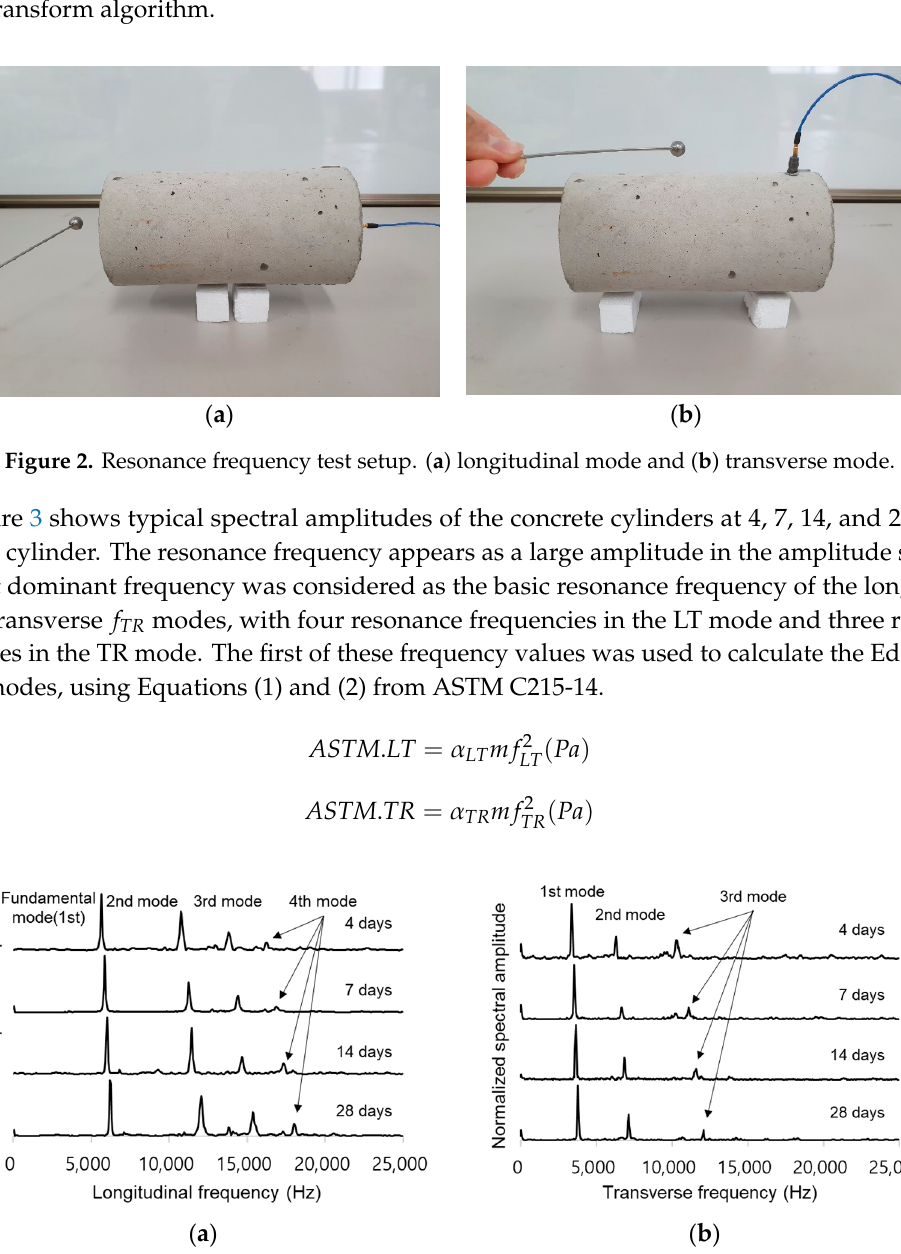
Figure 3. Resonance frequency by curing ages according to ASTM resonance test. ( a ) frequencies of longitudinal mode, ( b ) frequencies of transverse mode.